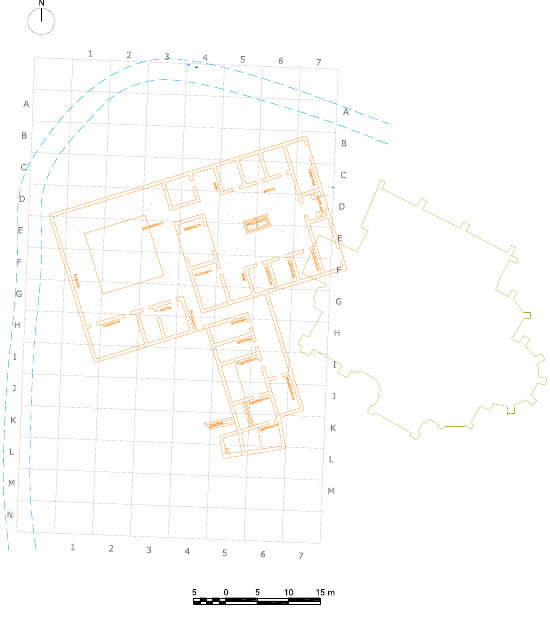
Figure 7: The outline of the Villa located over the archaeological remains which have been hidden for better